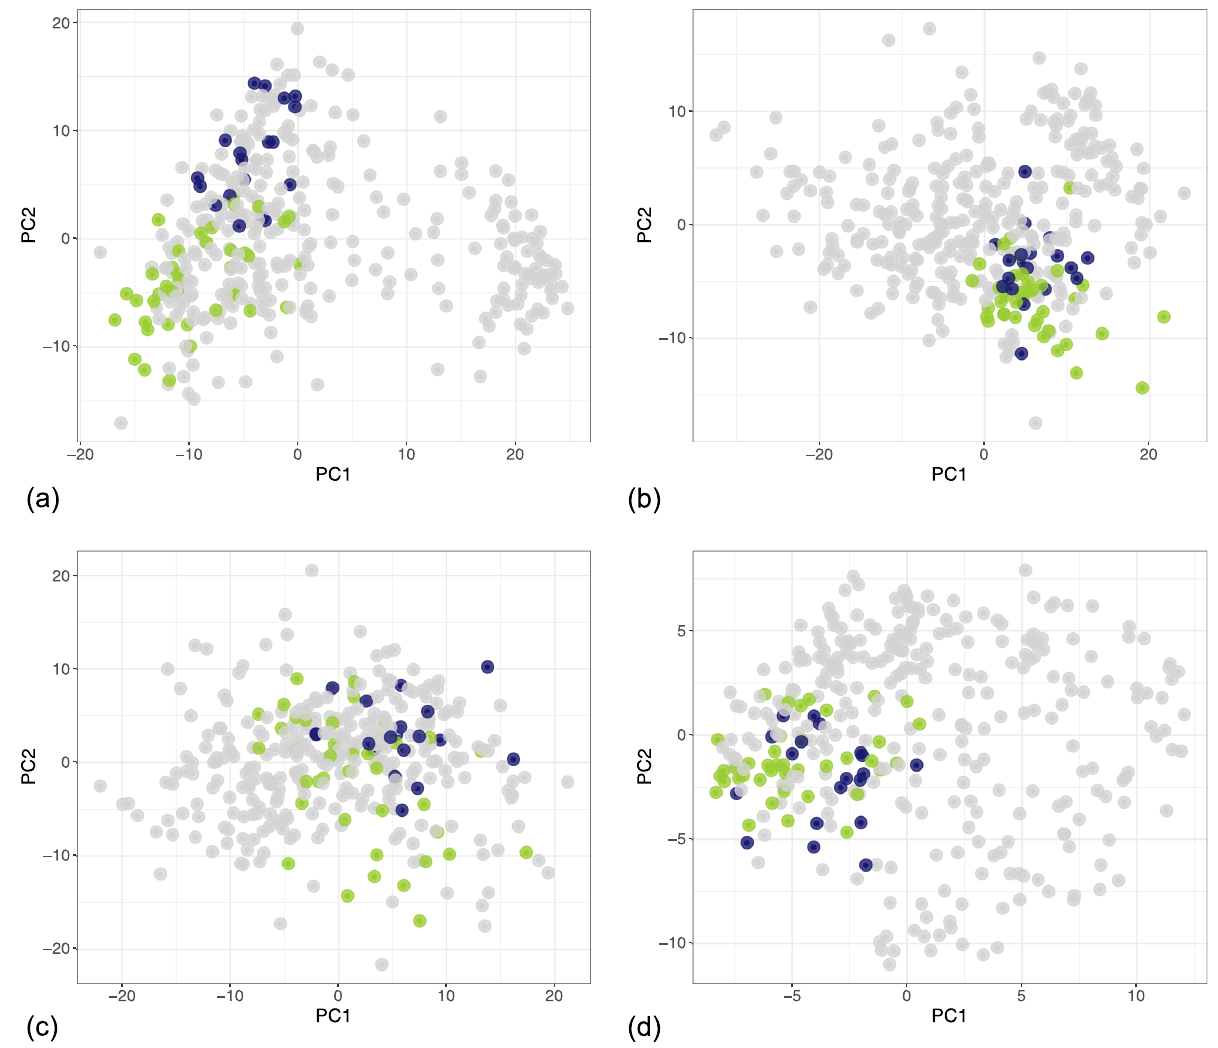
Fig 9. PCA projections of the global clusters identified in individual contexts in the breast cancer dataset from TCGA. The two highlightedclusters differ only in the gene expressioncontext but they are mergedin the other contexts. (a) Context 1 represents the gene expressiondataset where the two clusters are separate.(b) Context 2 represents the DNA methylationdataset. (c) Context 3 representsthe miRNA expressiondataset. (d) Context 4 corresponds to the RPPA dataset.